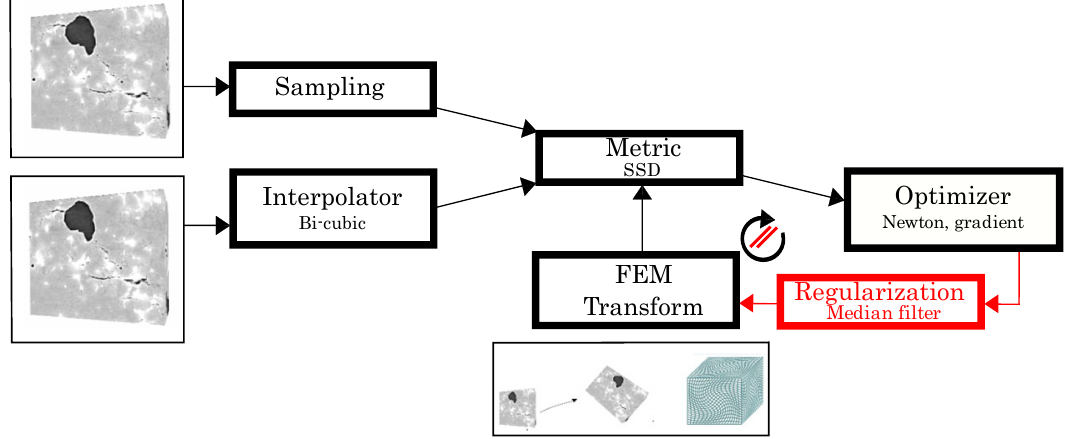
Figure 1. Di ff erent steps of the digital volume correlation (DVC) process with YaDICs software